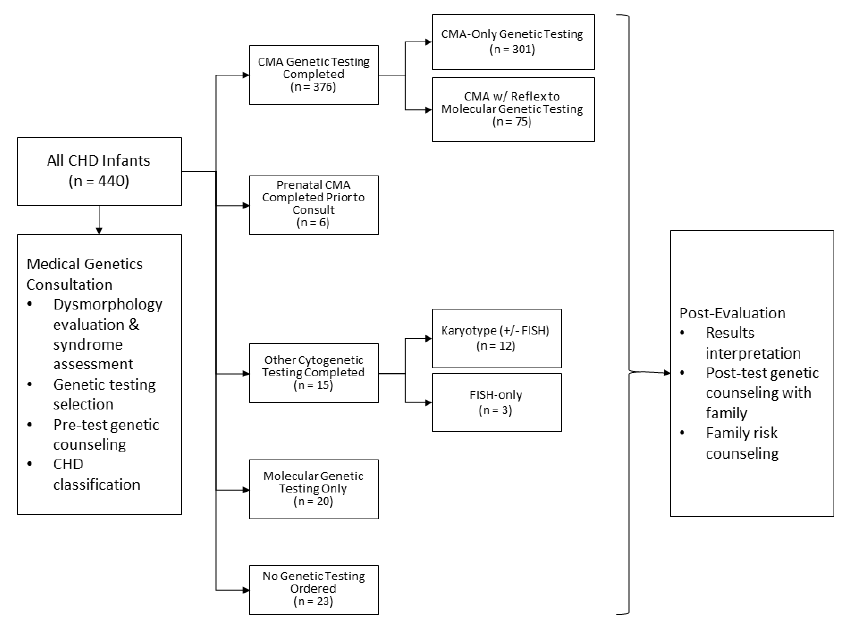
Figure 1. Genetic testing modalities used in evaluation of CHD inpatient cohort.